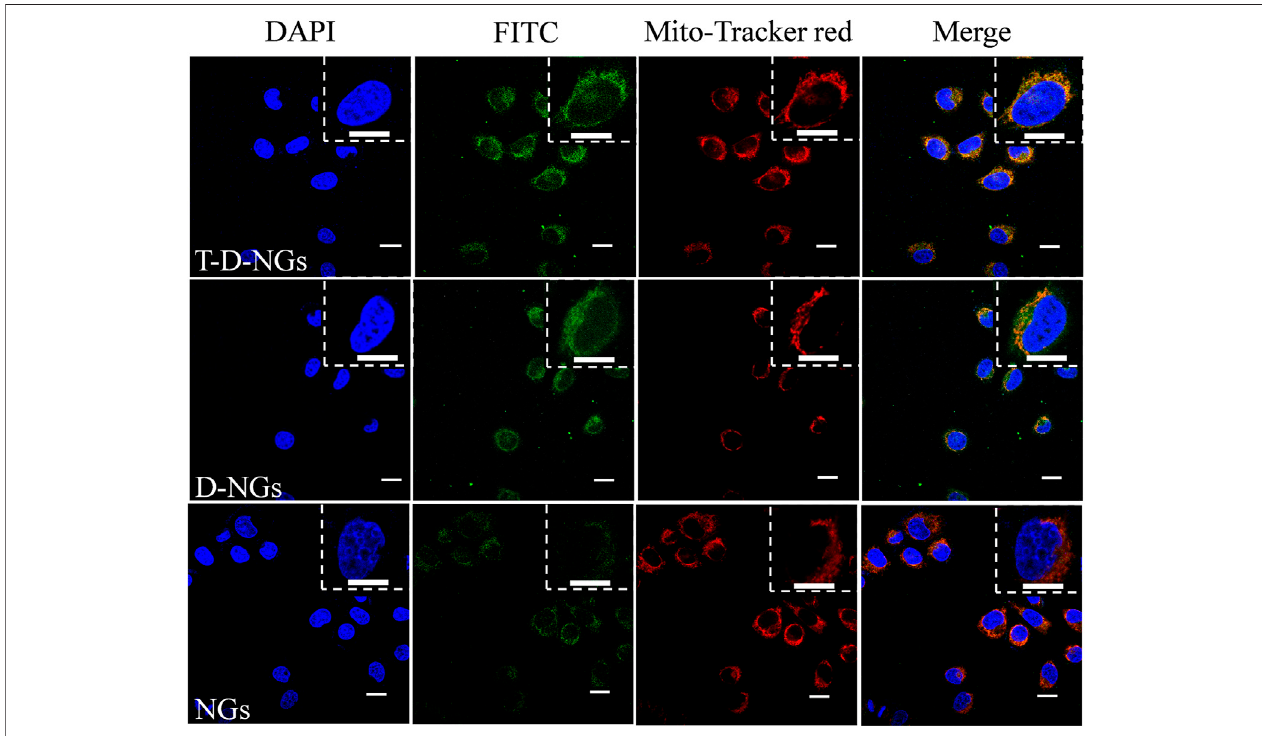
FIGURE4| CLSM images ofMCF-7/MDR cellstreatedwithdifferentFITC-labeled nanogels(500 μ g/ml)following12-hincubation. Themitochondriawerestained with MitoTracker Red, and the cell nuclei were stained with DAPI (blue signal). Scale bars: 20 μ m.